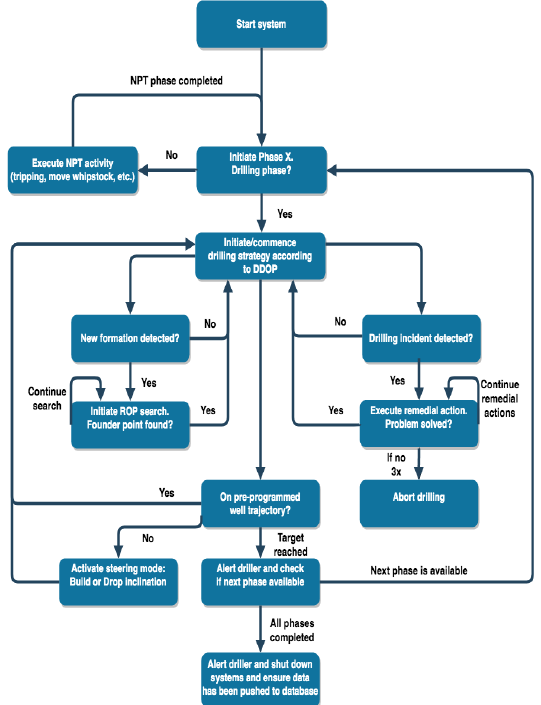
Figure 2: Simplified illustration of the logic behind the autonomous drilling